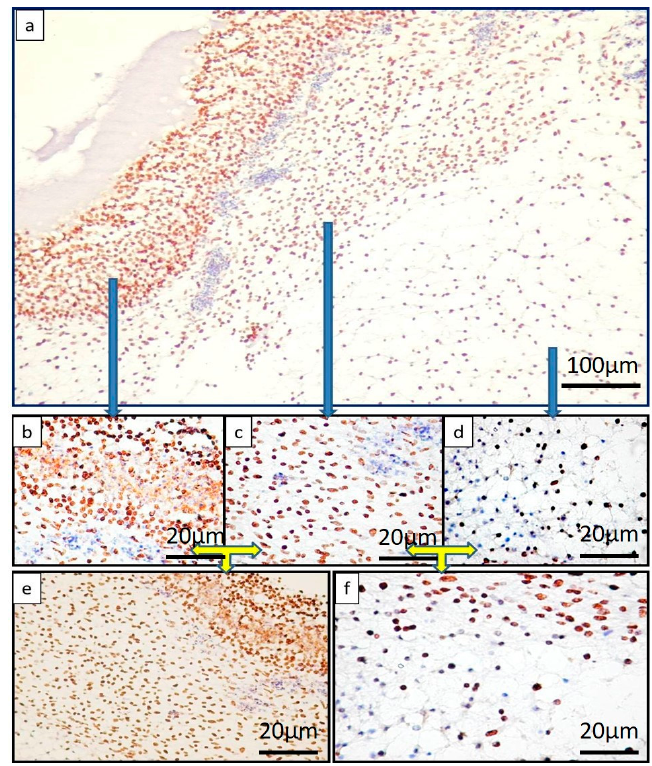
Figure 4. RUNX2 expression in BH treated samples, showing clearly the stratification of RUNX2 positive cells on distinct layers inside the CAM ( a ). RUNX2 positive cells (with nuclear pattern) had the highest density in the superficial layer ( b ) (with an average of 100 positive nuclei/field ×400 magnification), while layers below showed medium ( c ) (average of 70 positive nuclei/field ×400 magnification) and low density ( d ) (average of 50 positive nuclei/field ×400 magnification). Sharp limits in between layers can be shown based on the density of positive nuclei ( e ) between the superficial and middle layer, and ( f ) between the middle and the deep layer. Blue arrows indicate the detailed images from each three layers of BH treated samples. Yellow arrows show the limits between two consecutive layers and also highlighting differences regarding density of positive signals in between layers.